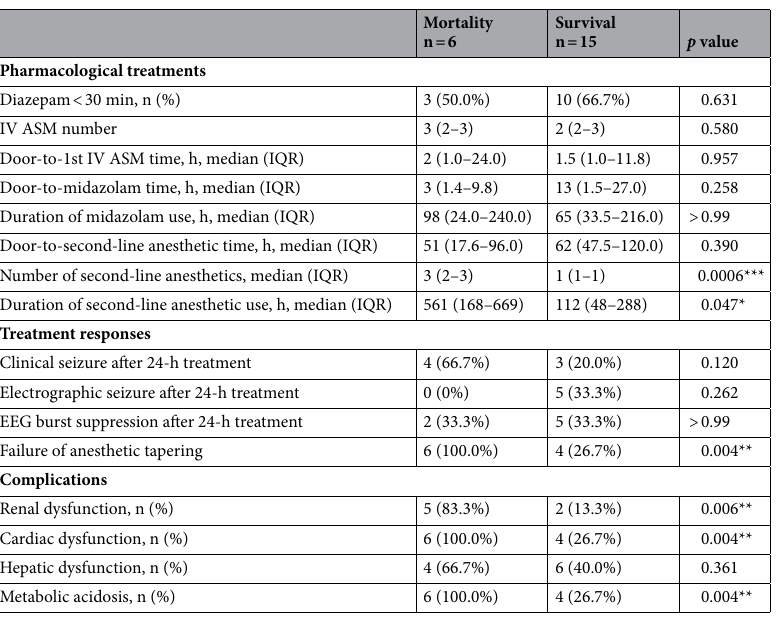
Table 2. Treatments, responses, and complications in patients with SRSE. n number, IQR interquartile range, IV ASM intravenous anti-seizure medication, SRSE super-refractory status epilepticus. * p < 0.05. ** p < 0.01. *** p <